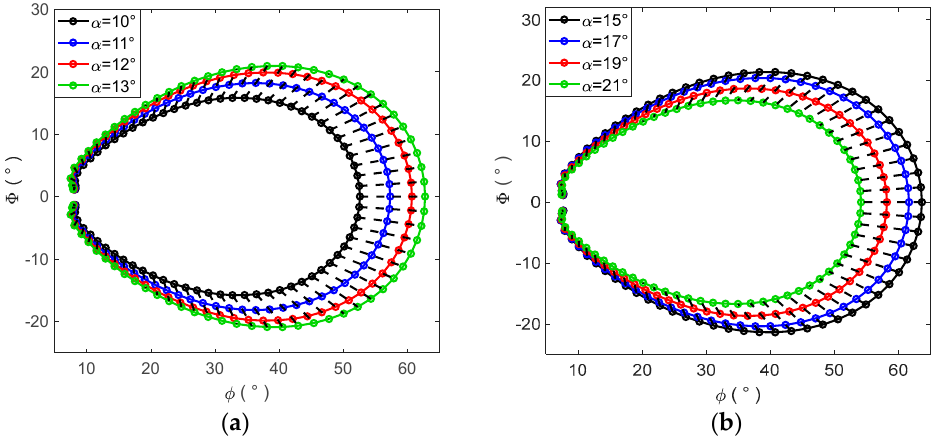
Figure 3. Fast initial trajectory setting method: ( a ) represents the change of landing points with a minor attack angle; ( b ) represents the change of landing points with a high attack angle.